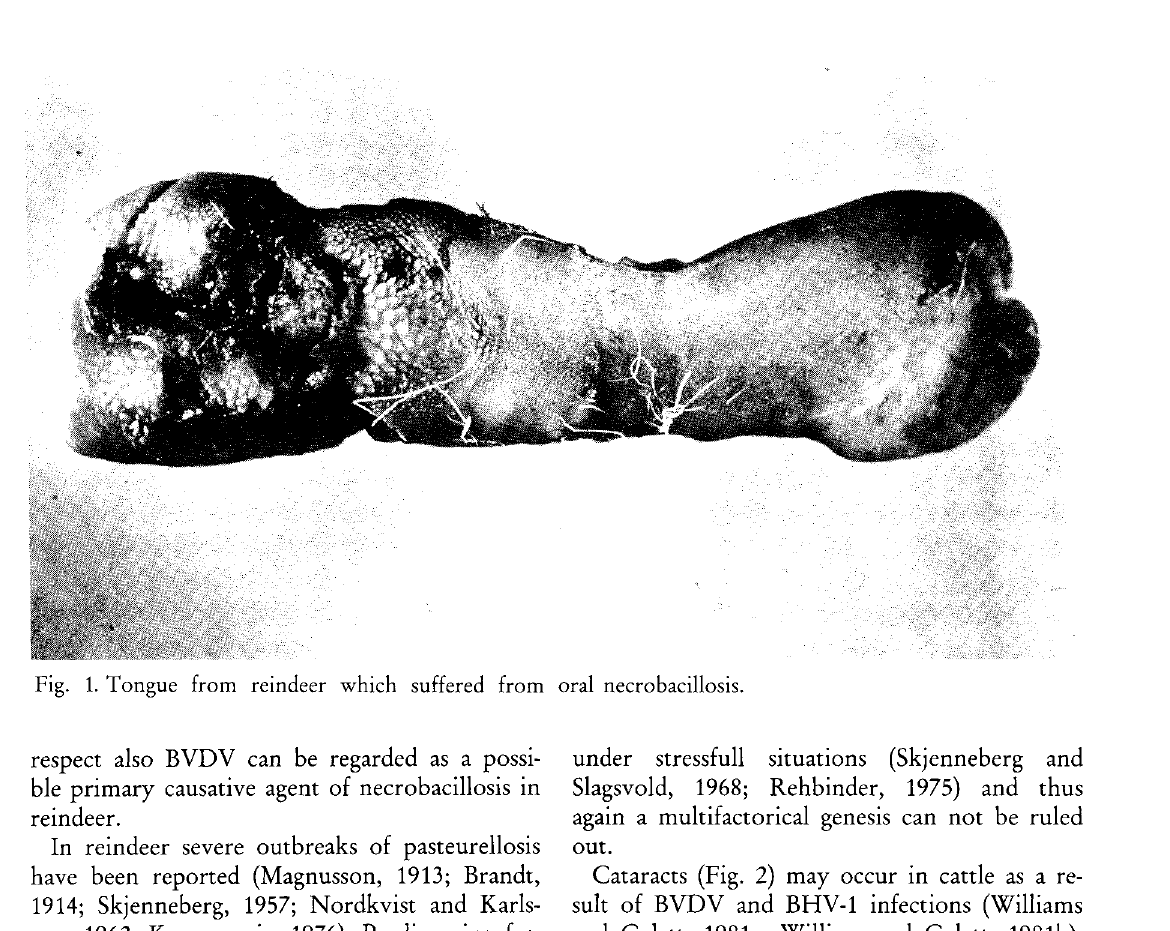
Fig. 1. Tongue from reindeer which suffered from oral necrobacillosis.